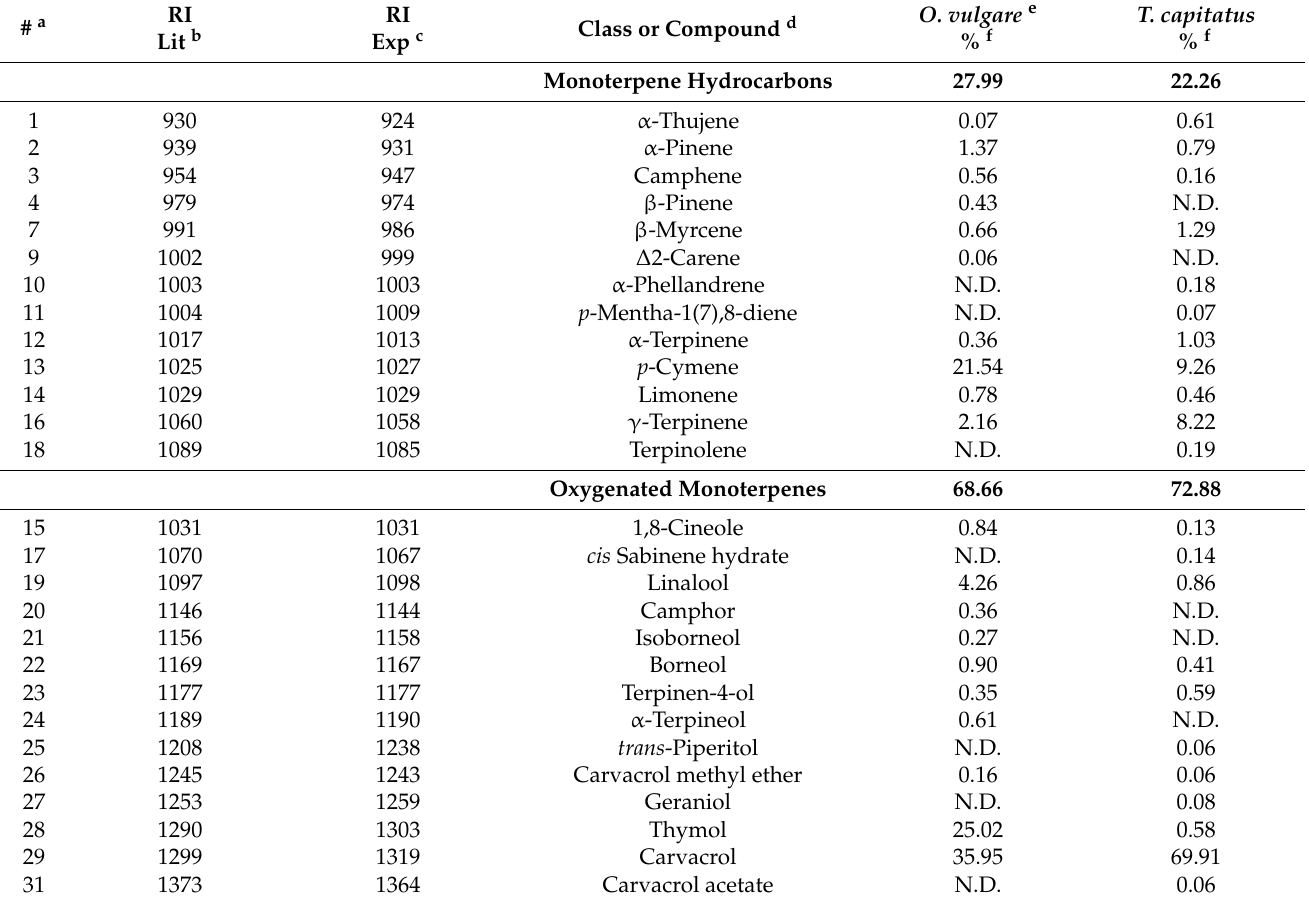
Table 1. Chemical composition of commercial Origanum vulgare and Thymus capitatus essential oils